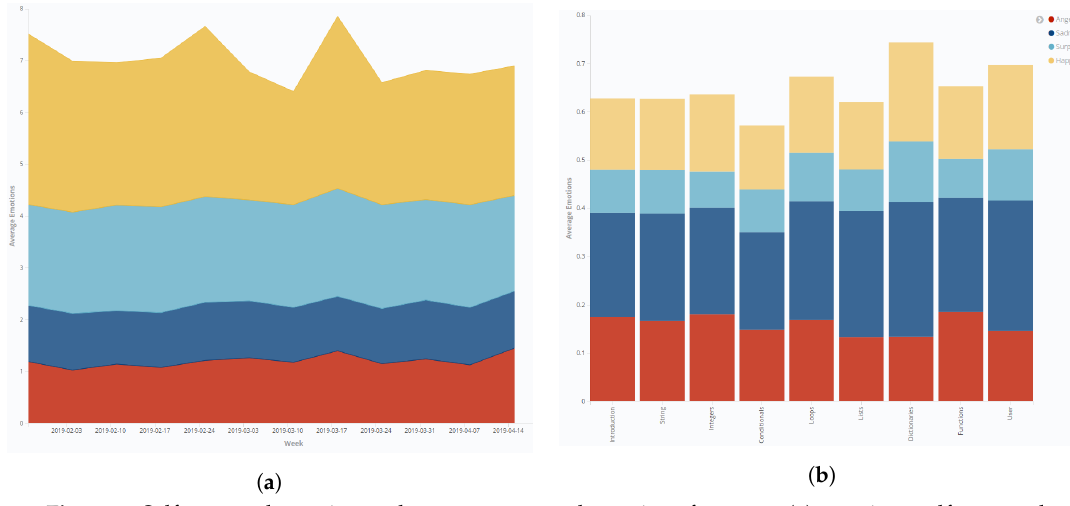
Figure 7. Self-reported emotion and average captured emotions for a test. ( a ) emotions self-reported by students shown per week; ( b ) example of the average captured emotions.